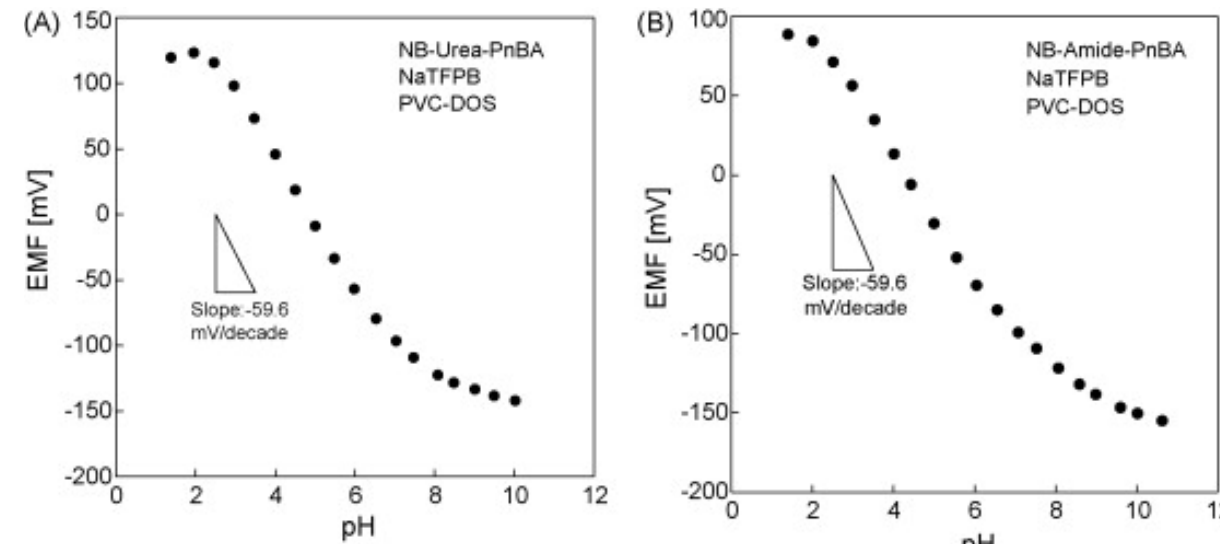
Figure 5. Potentiometric pH response of PVC–DOS membranes containing the two types of grafted Nile Blue derivatives, (A) NB-urea–PnBA (R2) and (B) NB-amide–PnBA (R2). Reprinted from [48] © 2007 with permission from